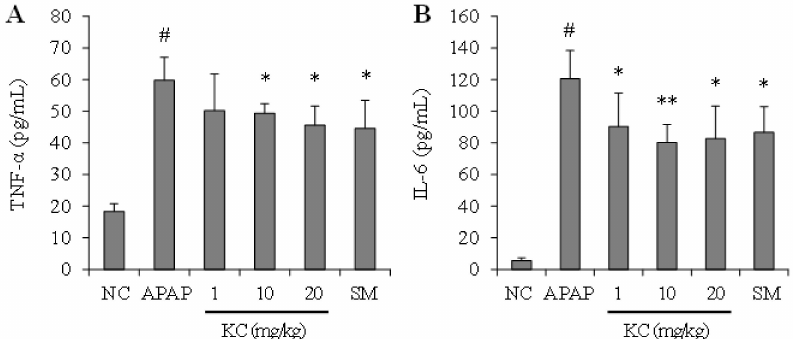
Figure 8. Effect of kushenol C on APAP-induced hepatic inflammation in mice. Thirty mice were partitioned into 6 groups (n = 5): group 1, normal control; group 2, APAP 500 mg/kg; group 3, APAP plus KC 1 mg/kg; group 4, APAP plus KC 10 mg/kg; group 5, APAP plus KC 20 mg/kg; group 6 (a positive control), APAP plus silymarin (SM) 50 mg/kg. TNF- α ( A ) and IL-6 ( B ) levels were measured in the serum of each mice. Error bars represent the mean ± SD, # p < 0.001 vs. NC group, * p < 0.05, ** p < 0.01 vs. APAP-only treated